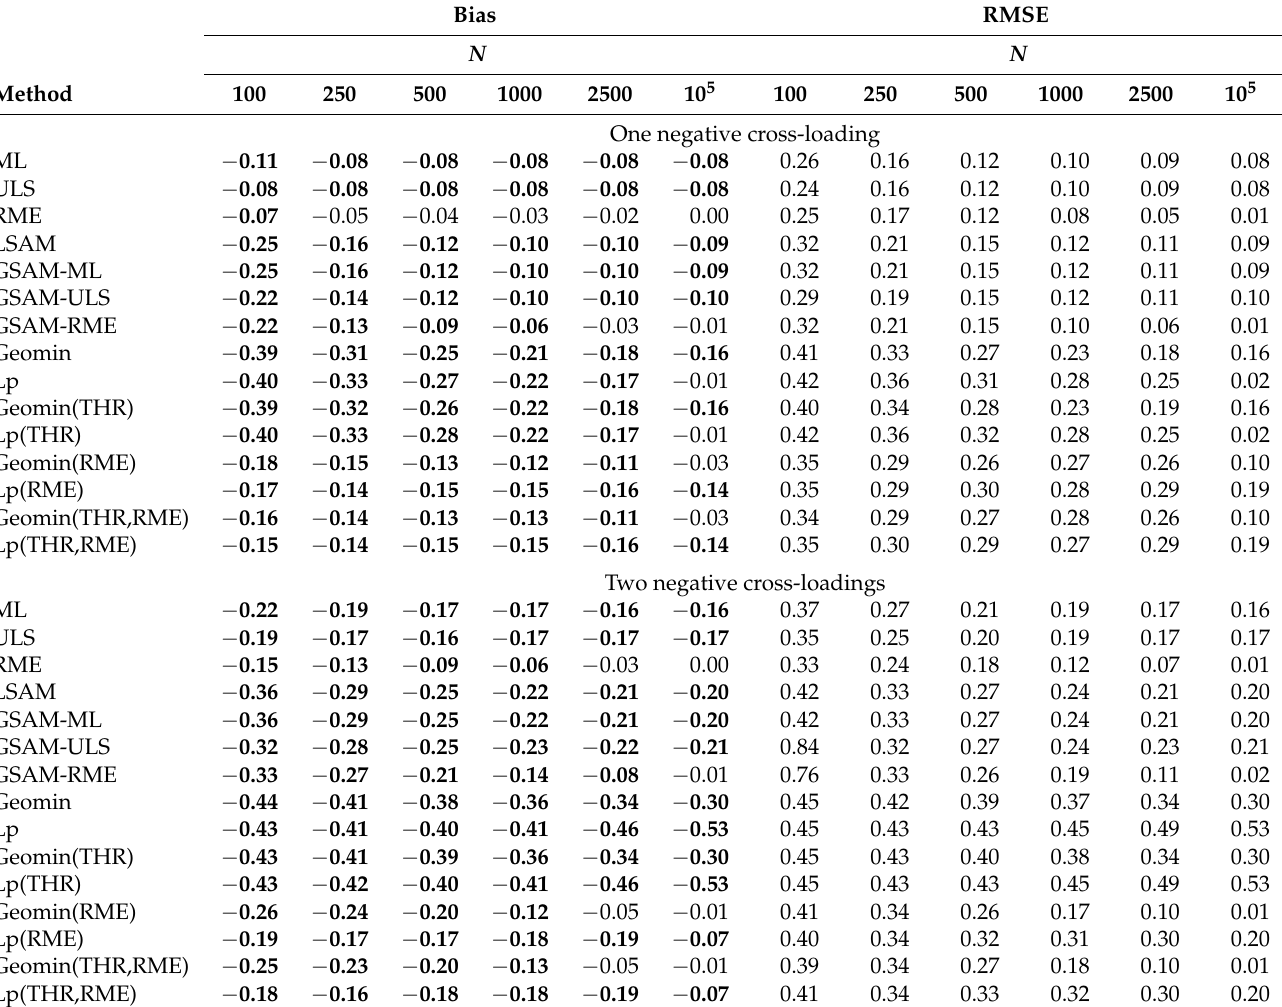
Table A2. Simulation Study 2 (two factors and cross loadings): bias and root mean square error (RMSE) of estimated factor correlation as a function of sample size with one and two negative cross loadings in the data-generating